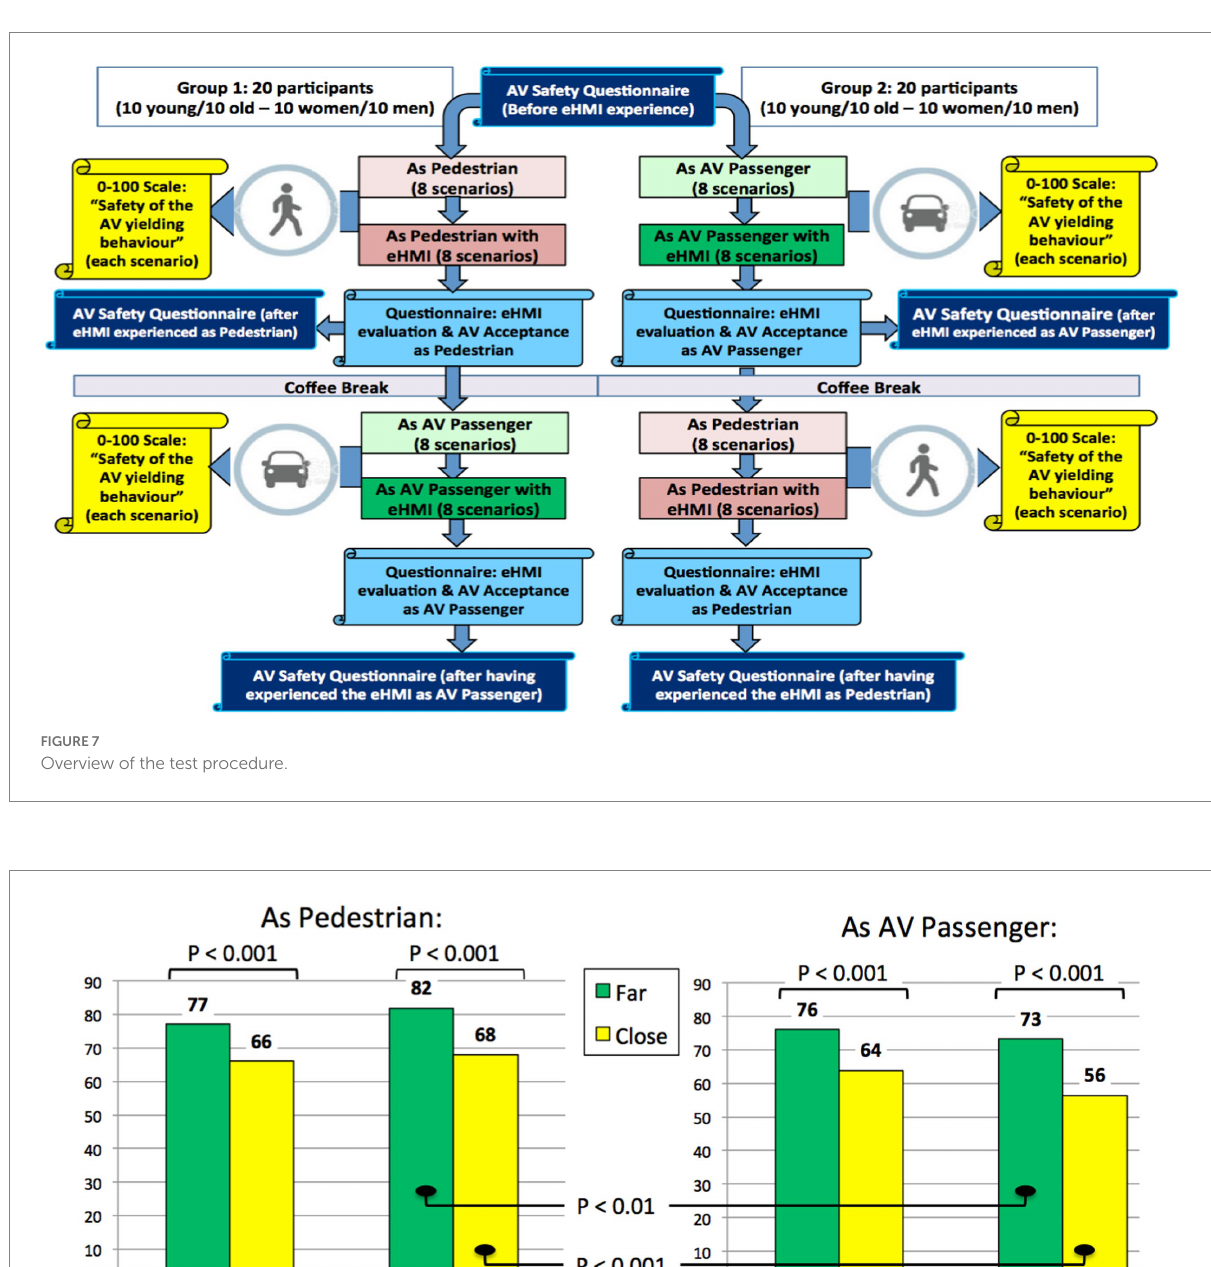
FIGURE 8 Perceived safety of the AV yielding behaviors according to the distance to